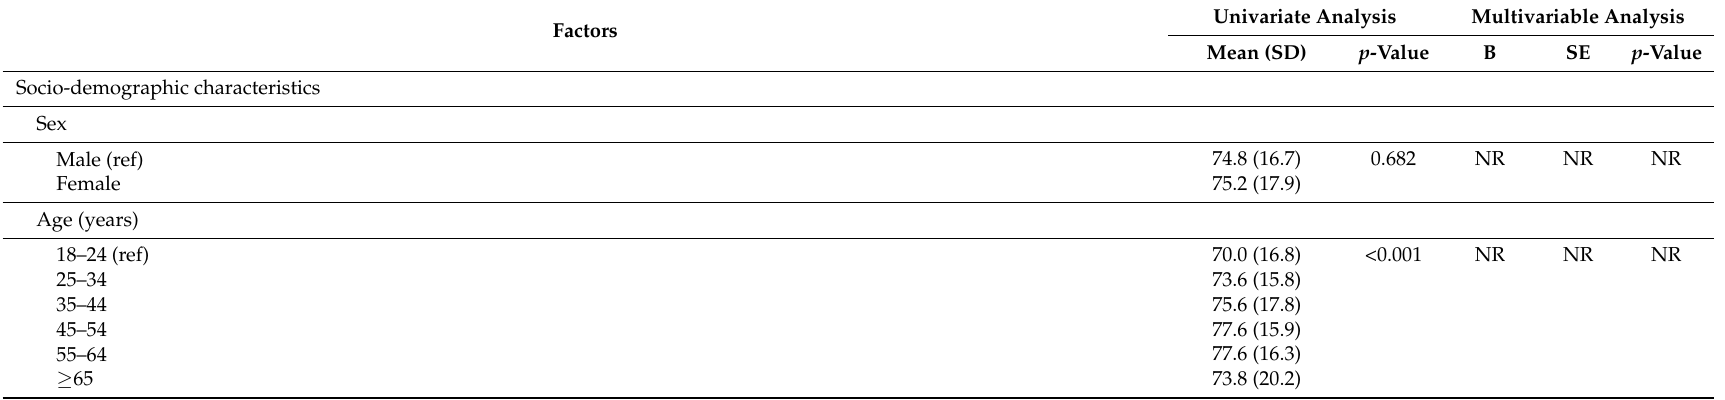
Table 5. Factors associated with the degree of acceptance on completing advance directives ( n =